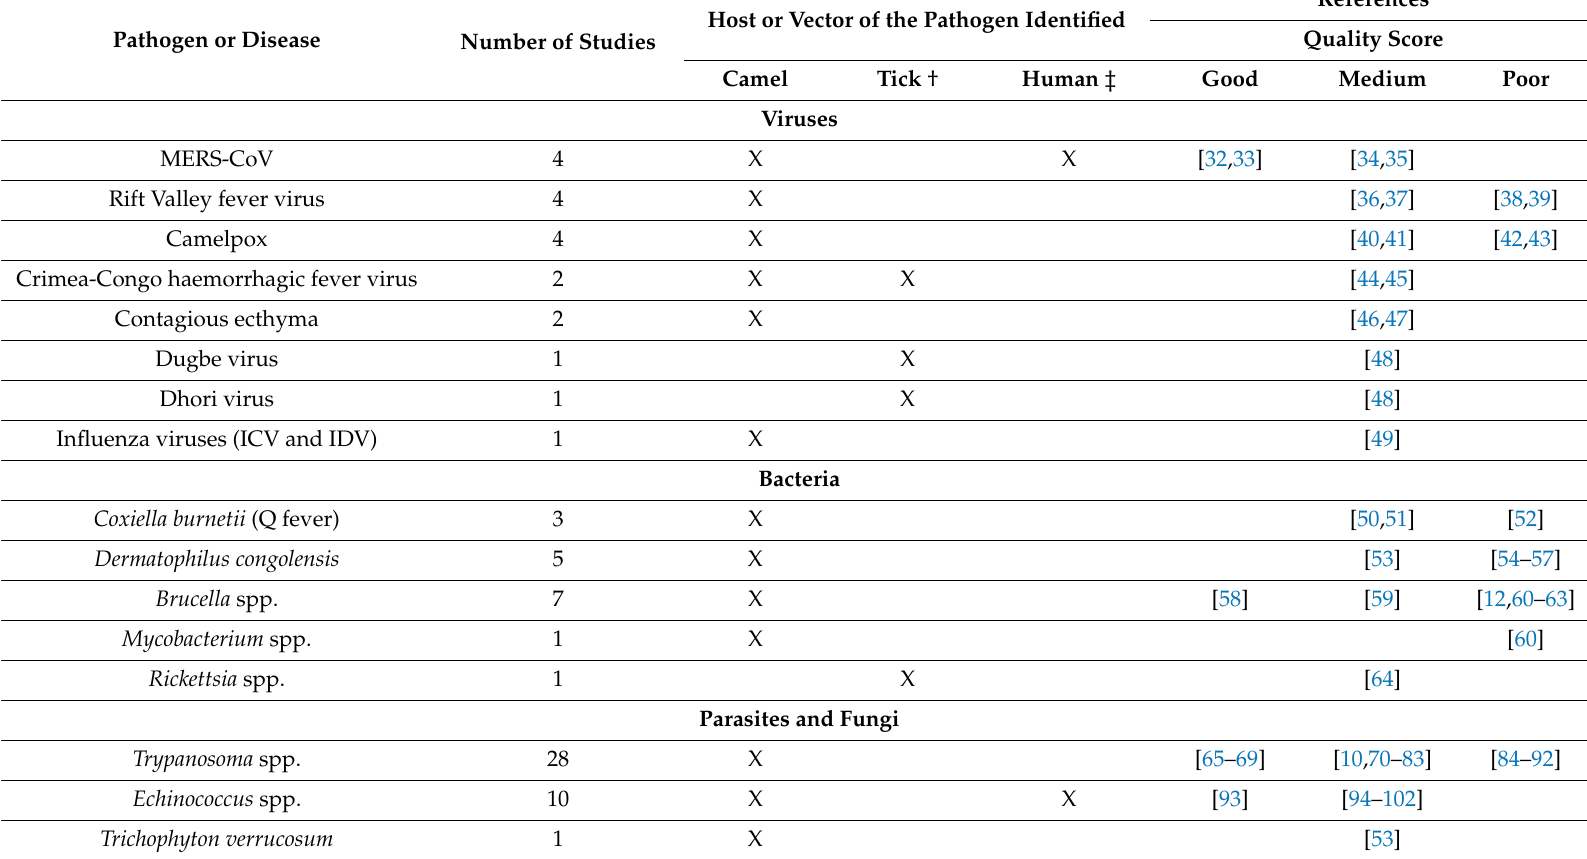
Table 3. Zoonotic pathogens of dromedary camels in Kenya: number of studies identified in this review and host species in which it was